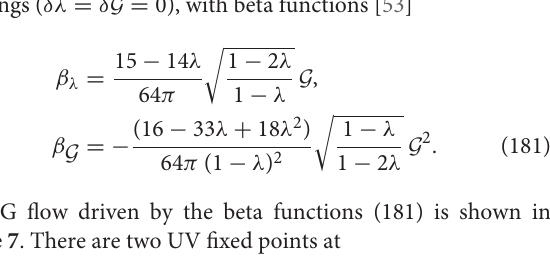
FIGURE 7 | RG flow of essential couplings in HG in D arrows point from the UV to the IR (from [